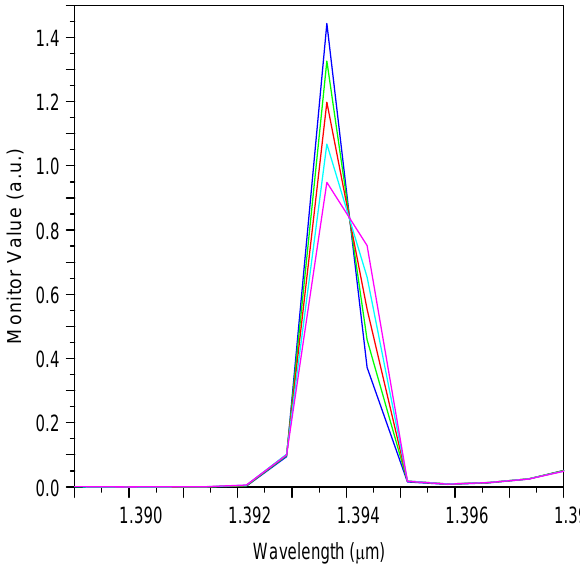
Fig.4. The resonant wavelength of various refractive indexes in SH . By increasing the refractive index in 1 sensing hole, the intensity of the transmission spectrum is shifted to lower